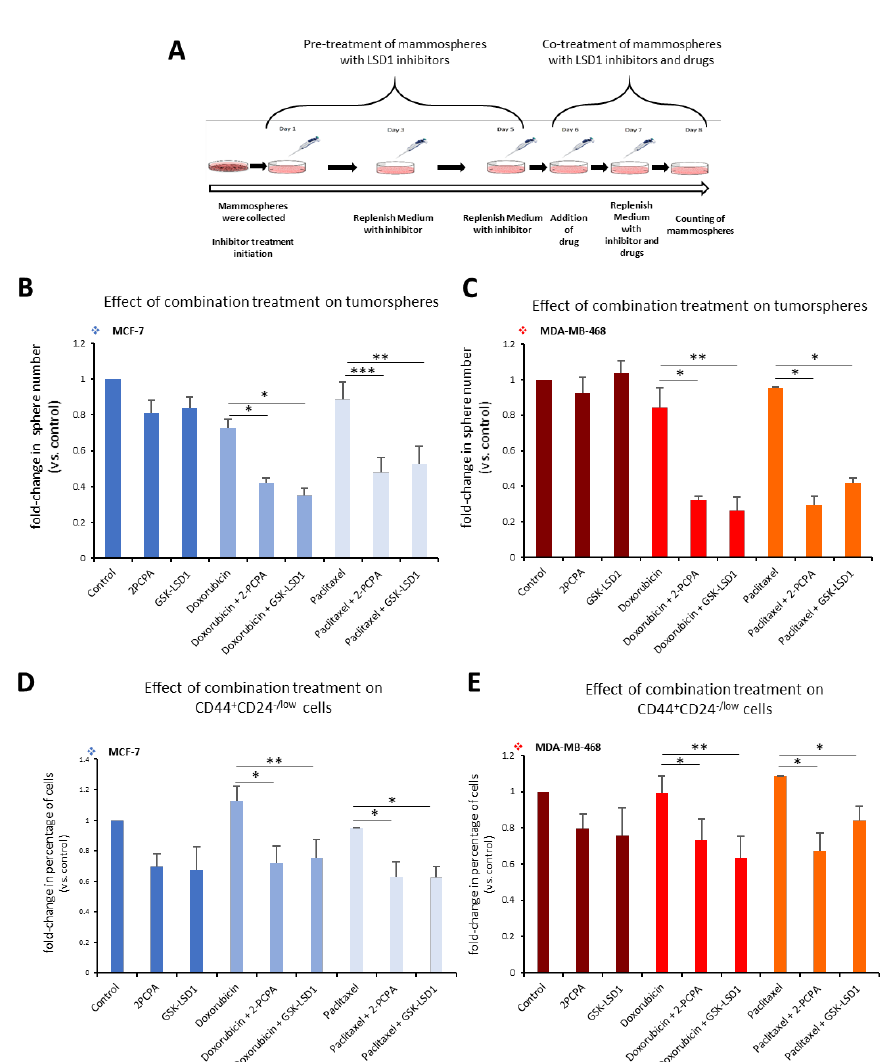
Figure 6. Combination treatment of breast tumorspheres with LSD1 inhibitors targets all cancer cells. ( A ) Schematic representation of combination treatment of tumorspheres with LSD1 inhibitors and an anti-cancer drug. MCF-7- and MDA-MB-468-derived tumorspheres were treated with 2-PCPA (50 µ M) or GSK-LSD1 (2 µ M) for 5 days. On the sixth day, doxorubicin (2.5 µ M) or paclitaxel (15 µ M) were added for two more days. On the last day of treatment, the number of tumorspheres was counted. ( B ) Graphical representation of the effects of combination treatment on MCF-7 tumorspheres. The dark blue panel depicts vehicle-treated, 2-PCPA- or GSK-LSD1-treated tumorspheres. The light blue panel depicts doxorubicin-treated tumorspheres, alone or in combination with an LSD1 inhibitor. The grey blue panel depicts paclitaxel-treated tumorspheres, alone or in combination with an LSD1 inhibitor. ( C ) Graphical representation of the effects of combination treatment on MDA-MB-468 tumorspheres. The dark red panel depicts vehicle-treated, 2-PCPA- or GSK-LSD1-treated tumorspheres. The red panel depicts doxorubicin-treated tumorspheres, alone or in combination with an LSD1 inhibitor. The orange panel depicts paclitaxel-treated tumorspheres, alone or in combination with an LSD1 inhibitor. ( D ) Graphical representation of FACS analysis data for the CD44 + CD24 -/low CSC subpopulation in MCF-7 tumorspheres. Colors depict the same conditions described in ( B ). ( E ) Graphical representation of FACS analysis data for the CD44 + CD24 -/low CSC subpopulation in MDA-MB-468 tumorspheres. Colors depict the same conditions described in ( C ). Error bars represent SEM. * p < 0.05, ** p < 0.01, *** p < 0.001.